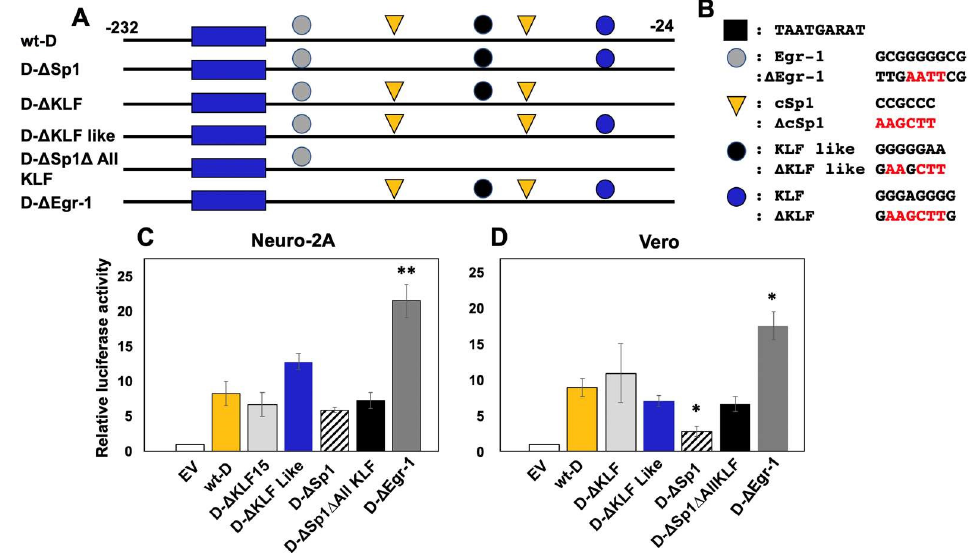
Figure 6. Examination of transcriptional activation of a minimal promoter by fragment D. ( Panel A ): ICP0 wt − D fragment, location of transcription factor binding sites, and schematic of the respective mutants are shown. All constructs were cloned upstream of the minimal promoter of pGL4.24[luc2P/minP]. Nucleotide position numbers are shown relative to the transcription initiation site of ICP0 mRNA. ( Panel B ): nucleotide sequences of Sp1, KLF, KLF-like, and Egr − 1 sites, and the respective mutants (red) are shown. Neuro − 2A ( Panel C ) or Vero ( Panel D ) cells were incubated in 2% stripped FBS and transfected with 0.5 ug of the wt − D construct or denoted mutants and Renilla luciferase expression plasmid (0.05 ug). 48 hrs after transfection, cells were harvested, and dual luciferase assays were performed. Luciferase activity was calculated relative to pGL4.24[luc2P/minP] for each construct. Results are the mean of three experiments, and error bars indicate standard error. The * and ** denote a significant difference of p < 0.05 and p < 0.005 respectively compared to the wt − D CRM luciferase activity as determined by Student’s t − test. Statistical analysis was performed as described in Materials and